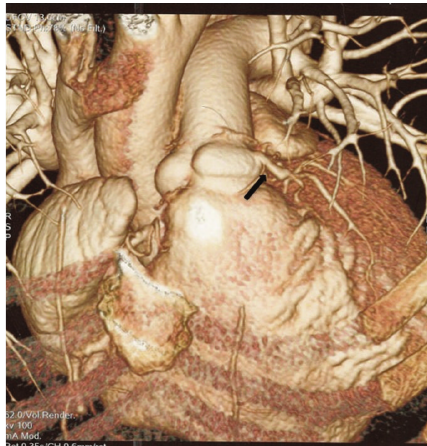
Figure 2: Cardiac CT demonstrating aortic right ventricular fistula.